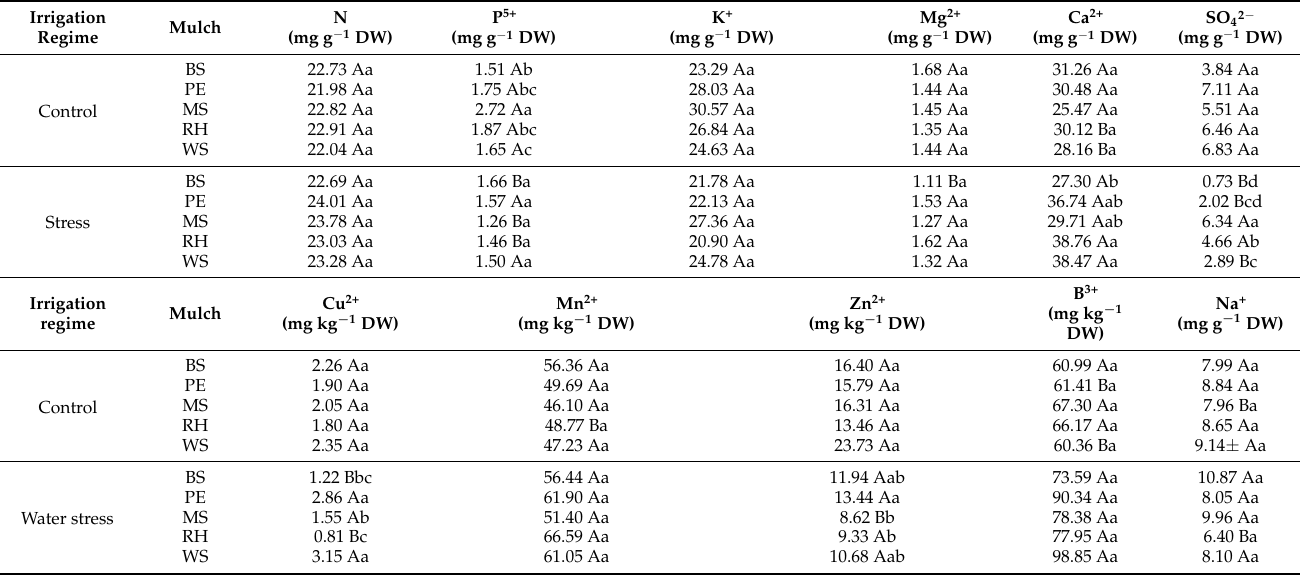
Table 3. Mineral nutrient concentrations in leaves of artichoke plants (cv. Symphony) cultivated under different mulching and irrigation